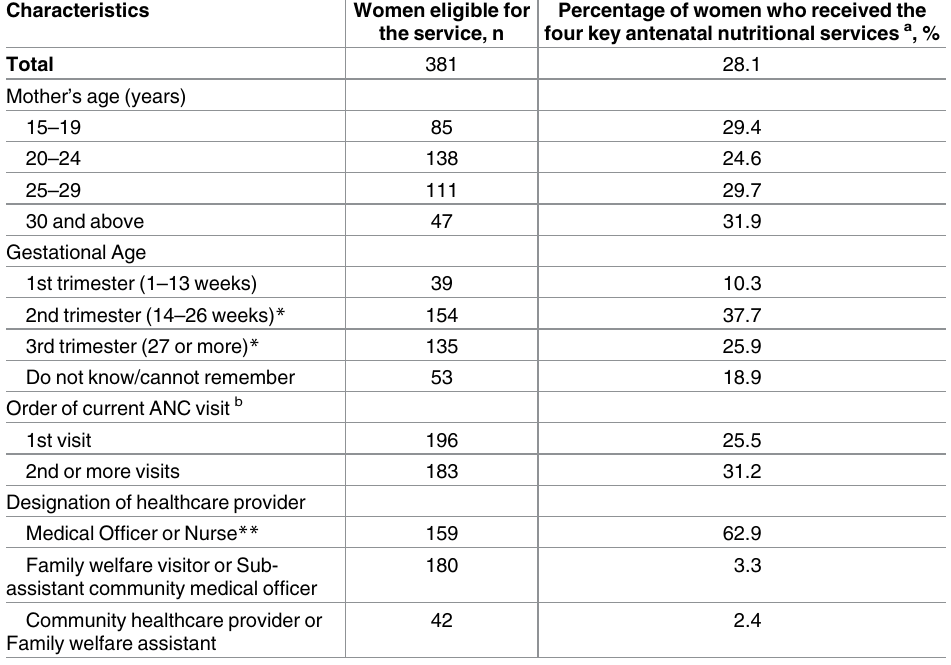
Table 5. Characteristics of women who receivedthe four key nutritional servicesduring antenatal care.